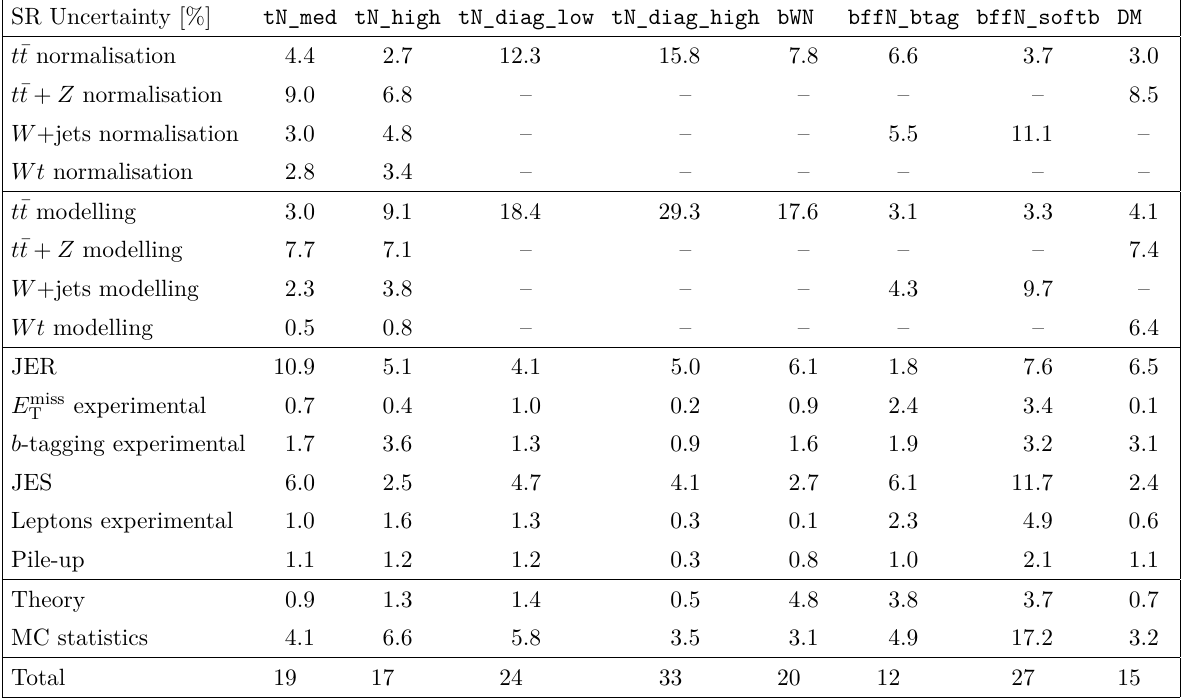
Table 13. Summary of the dominant systematic uncertainties as a percentage of the total predicted background yields in the SRs, obtained from the background-only fits described in section